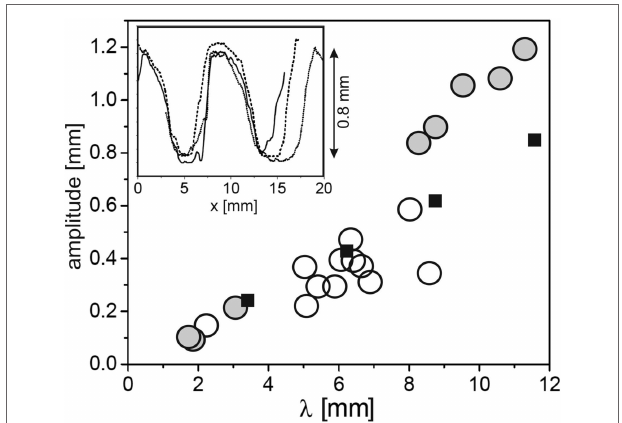
FIGURE 2 | Topographic characteristics of Kinneyia fossils and their models generated in the laboratory . Circles : crest-to-valley amplitude of Kinneyia ripples as a function of their wavelength for fossils from Namibia (Neuras (gray) and Haruchas (white) outcrop). The symbol size roughly corresponds to the observational error. Squares : saturation amplitudes of artificial Kinneyia structures generated in the laboratory. Inset : sample profiles as taken from a fossil mold cast [adapted with modifications from Thomas et al.